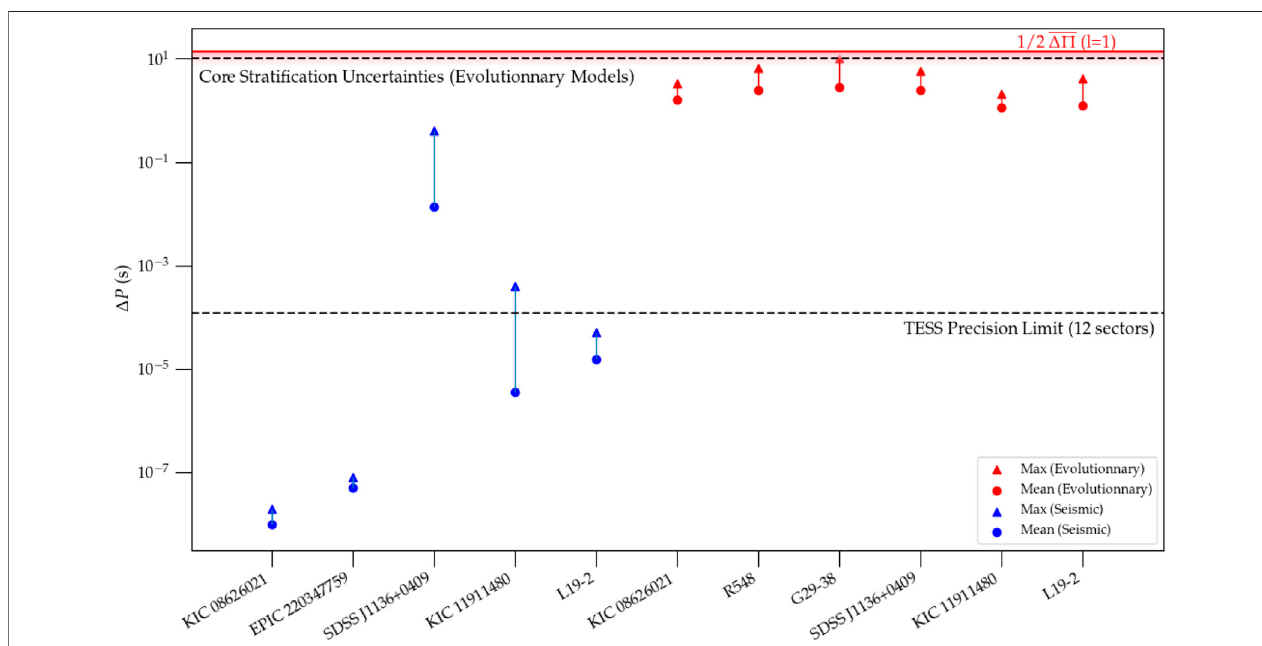
FIGURE10| Mean and maximum period differences,on alogarithmic scale, betweentheobservedand computed periodsforthe DAVpulsators presented in this work and the DBV KIC08626021 (Giammichele et al., 2018) using our new parametrized seismic models (in blue), compared to results obtained with full evolutionary models (in red) for the same stars, when available (KIC08626021:Córsico et al. (2012), R548, G29-38, and L19-2:Romero et al. (2012), SDSSJ1136 + 0409, KIC11911480:Romero et al. (2017)). We also indicate with a red horizontal line, half the value of the mean period spacing calculated for a typical DAV star of ~ 0 . 6 M ⊙ (with T eff =12000 K , log g = 8.0) for ℓ =1periods. Reaching this limit isanobjective criteriatoassess theinconclusiveness ofa fi t. Wealso pinpointanestimate oftheobservationalprecisionlimitoftheTESSsatellitemission(basedon12combinedsectors).Alsoofrelevance,wehighlightthemagnitudeofuncertaintyarisingfrom the core chemical strati fi cation when using full evolutionary